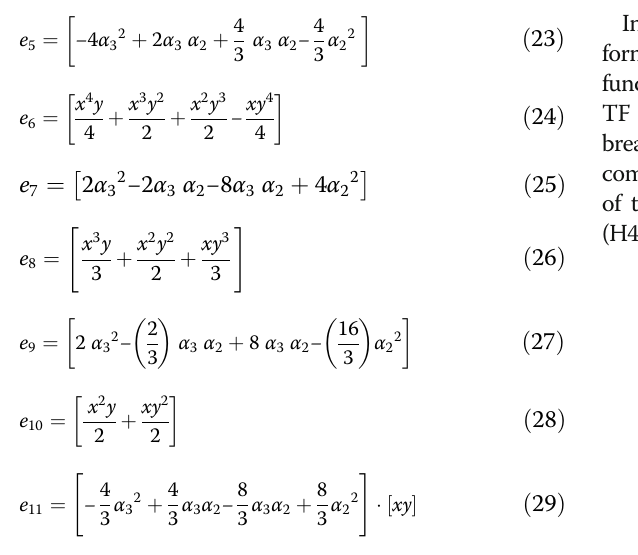
Characterization of ICF of bivariate cubic B-spline model polynomial function (H42D)